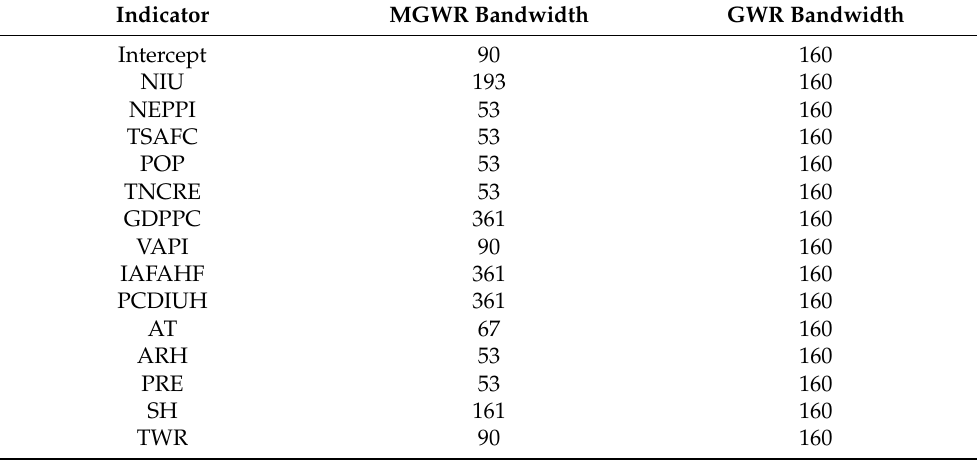
Table 14. MGWR bandwidth.